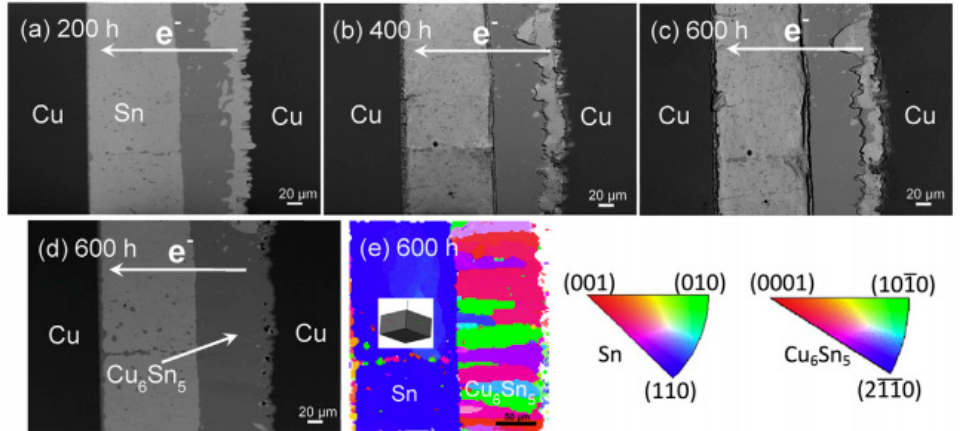
Figure 5. Cross-sectional microstructures of the sample after EM for ( a ) 200 h, ( b ) 400 h, ( c ) 600 h, ( d ) 600 h (polished), and ( e ) EBSD inverse pole figure orientation image map Reprinted with permission from Ref. [48] Copyright 2016 Elsevier.